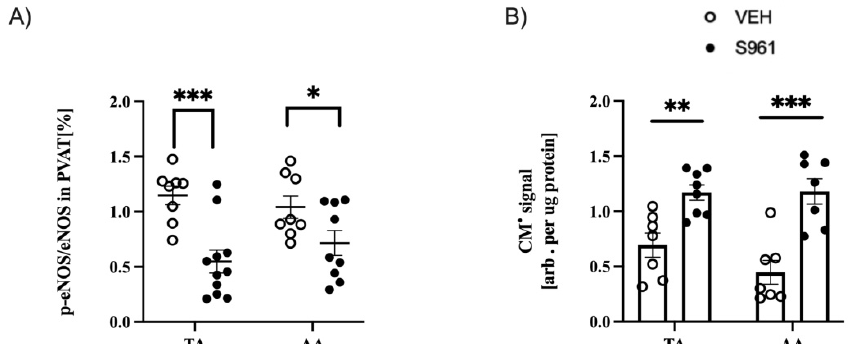
Figure 6. Effects of S961 treatment on eNOS activity and ROS production in PVAT and adiponec- tin expression. ( A ) Reduction eNOS activity in both TA (VEH n = 8, S961 n = 11) and AA (VEH n